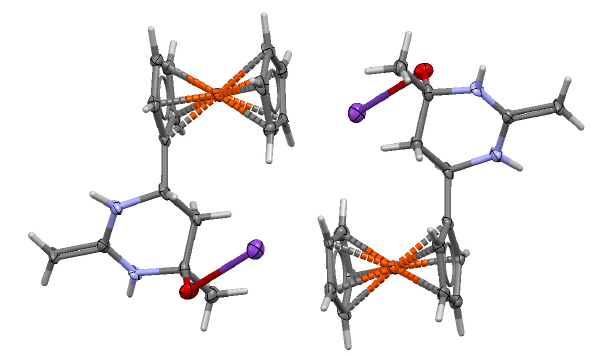
Figure 3. Structure of the fragment of unit cell of 7 .